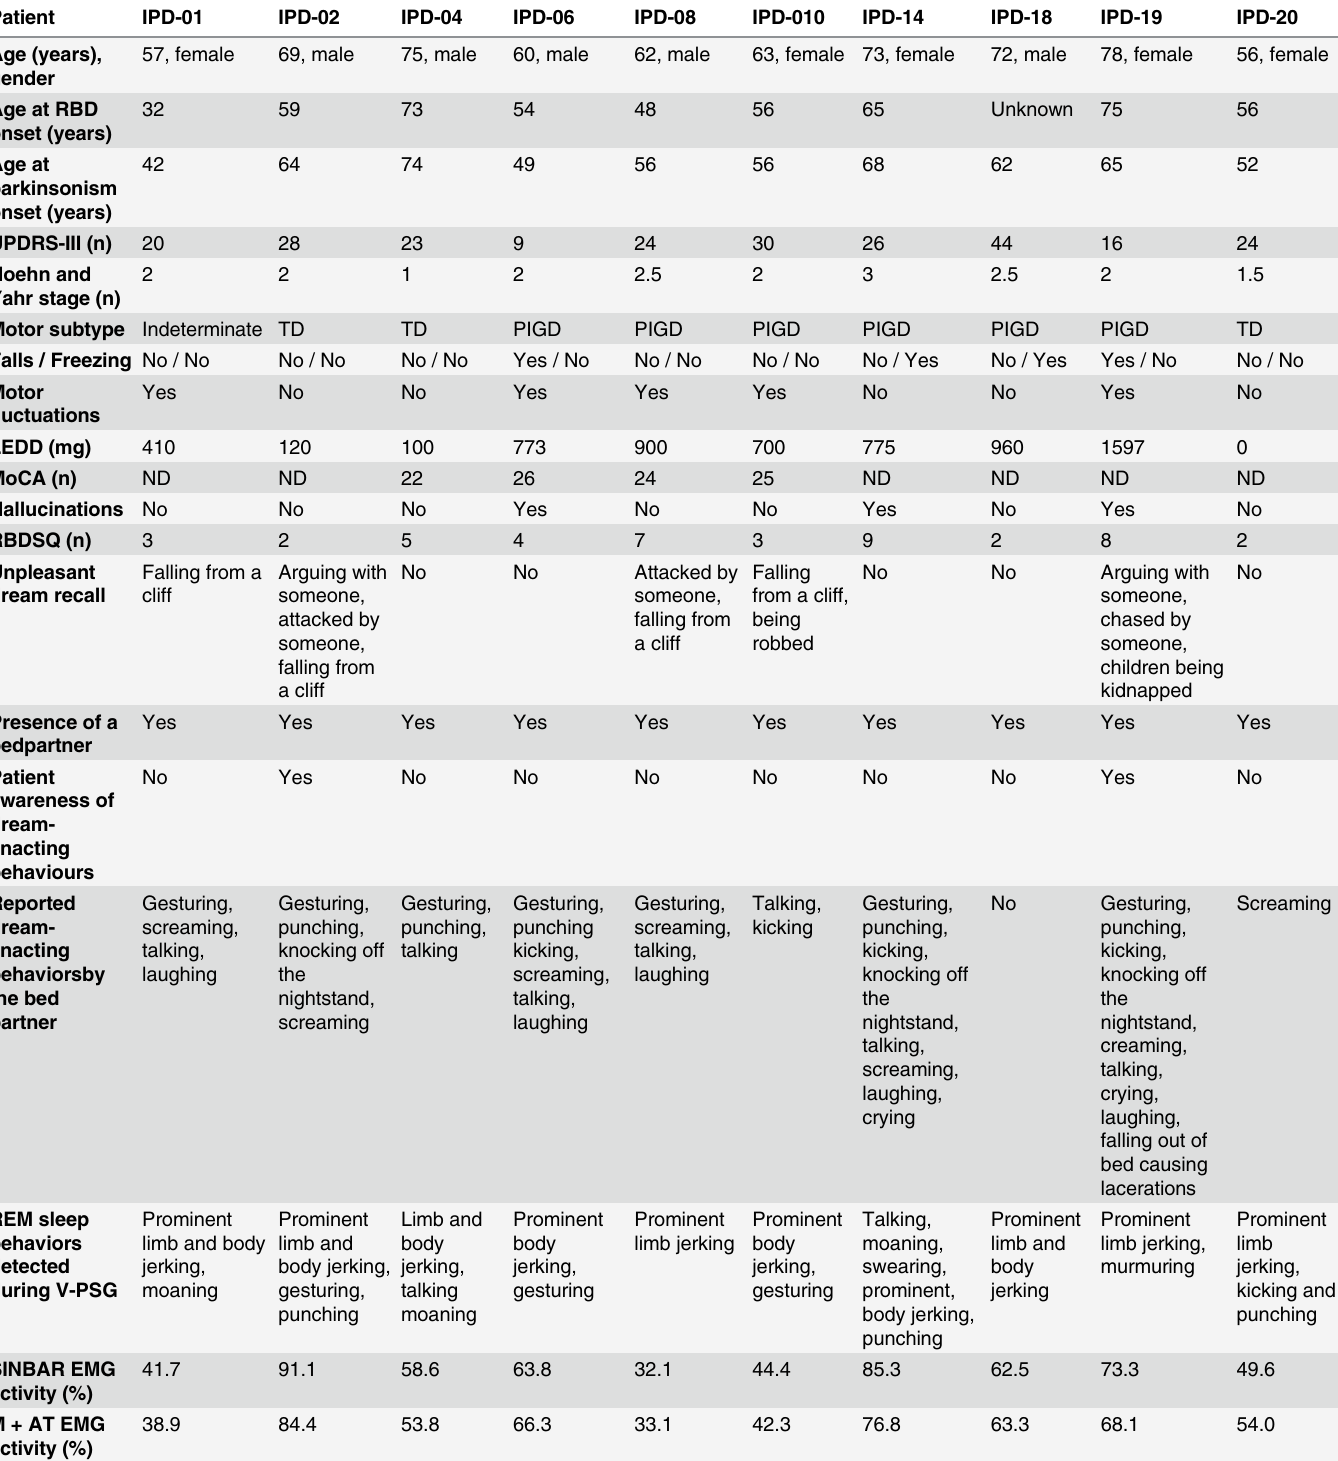
Table 6. Patients with idiopathic Parkinson Disease associated with REM sleep behavior